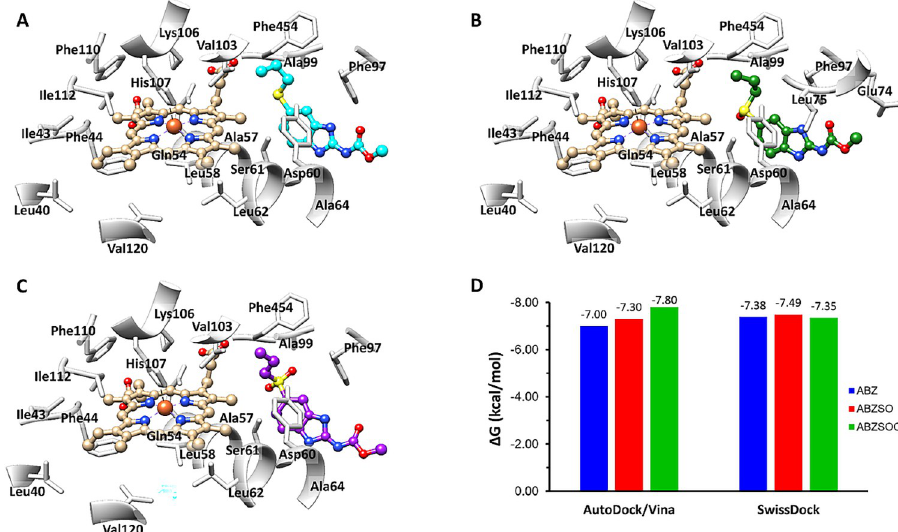
Fig 5. Docking positions and molecular interactions of drugs at the active site of gFlHb. Optimal dockings for (A) Albendazole (RMSD = 3.9 Å ), (B) Albendazole sulfoxide (RMSD = 3.0 Å ), (C) Albendazole sulfone (RMSD = 2.8.2 Å ) were obtained and are shown with residues of the catalytic site. (D) Predicted affinities for ABZ, ABZSO and ABZSOO to gFlHb using AutoDock/Vina and